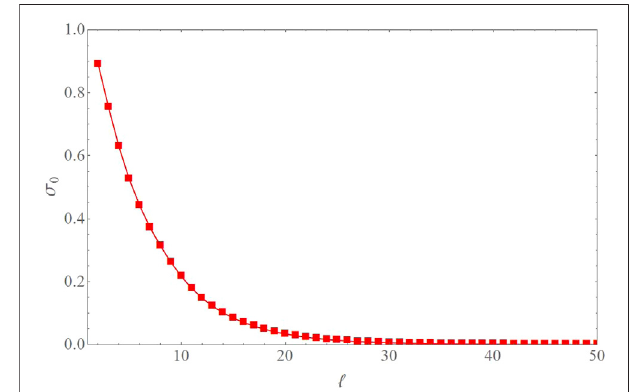
FIGURE 5 | Root-mean-square of the monopolar modulation σ 0 ( ℓ ) generated in LQC. Note the dependence of σ 0 on ℓ . The scale dependence introduced by the bounce in LQC makes the effects of the modulation signi fi cant only for ℓ ≲